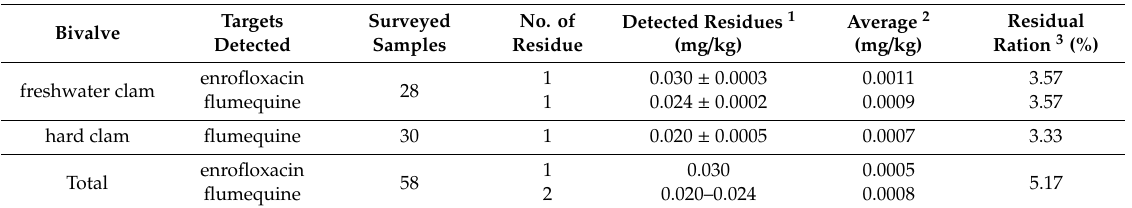
Table 1. Residual detection of banned quinolones in bivalve samples obtained from June 2018